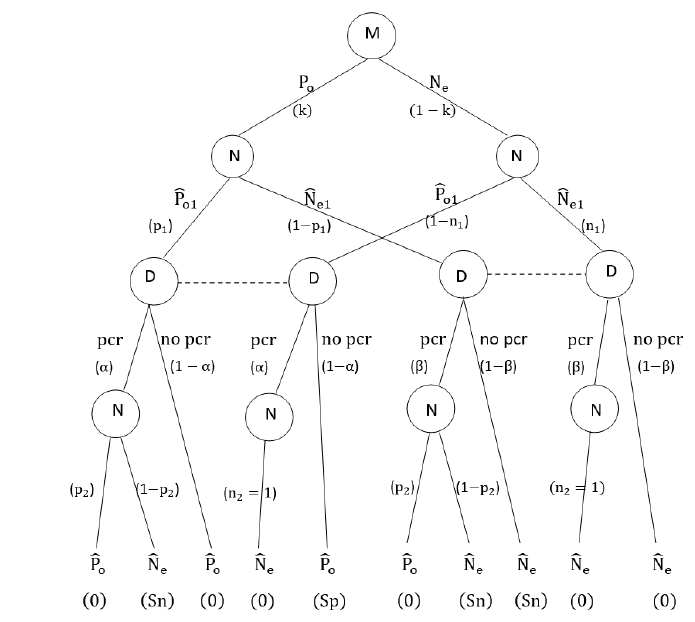
Fig. 1. Decision Tree for Two-Stage